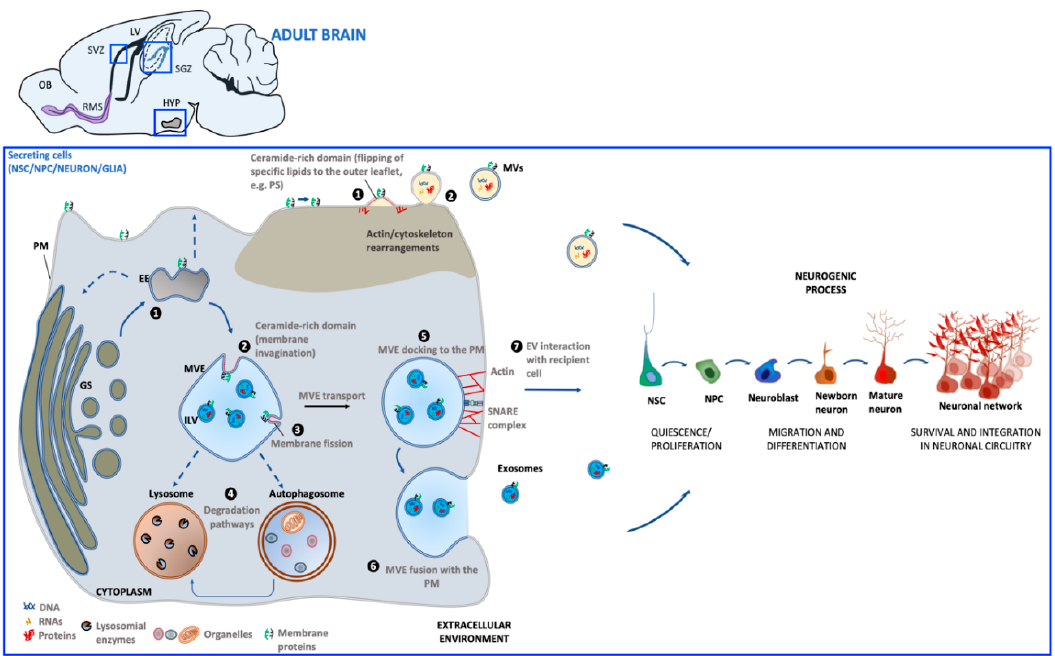
Figure 1. Schematic representation of extracellular vesicles’ (EV) biogenesis and release in the adult neurogenic niche. Biogenesis of microvesicles (MVs) ( brown background ) involves molecular machineries and membrane microdomains that promote the outward budding of the PM (1), followed by MV release in the extracellular environment (2). Exosome biogenesis ( blue background ) occurs upon maturation of early endosomes (EE) derived from the Golgi system (GS) into multivesicular endosomes (MVEs). Alternatively, EE can undergo retrograde transport to GS ( dashed arrows ) or recycling back to the PM ( dashed arrows ) (1). Exosomes are generated through membrane invagination of MVE (2), followed by ILV formation (3). Once matured, MVEs can be targeted to lysosomes / autophagosomes for cargo degradation (4), or be directed towards the PM (5). MVE fusion with PM (6) allows for exosome extracellular release (7). Both MV and exosome interaction with recipient cells can influence steps of the neurogenic process. [PM: plasma membrane; PS: phosphatidylserine; ILV: intraluminal vesicle; OB: olfactory bulb; SVZ: subventricular zone; SGZ: subgranular zone; HYP: hypothalamus; LV: lateral ventricle; RMS: rostral migratory system]. Exosomes (30–100 nm) derive from the endosomal compartment. Their formation starts with the generation of multivesicular endosomes (MVEs), spherical endosomes consisting of a limiting membrane